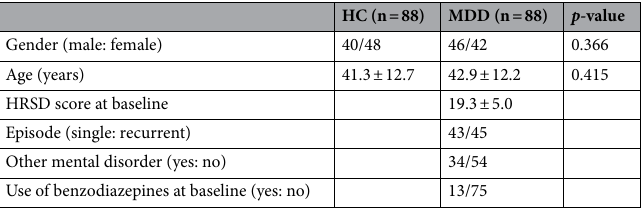
Table 1. Demographic and clinical characteristics of the patients with major depressive disorder (MDD) and healthy controls